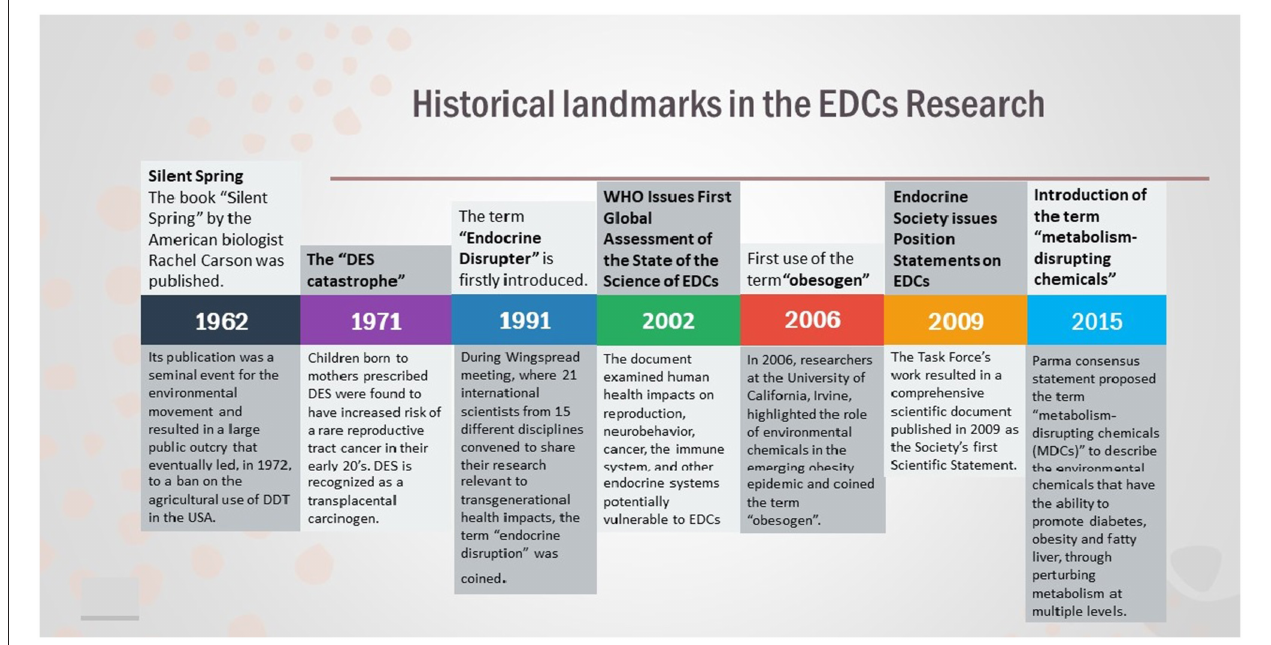
FIGURE 1 | Historical landmarks in the field of EDCs